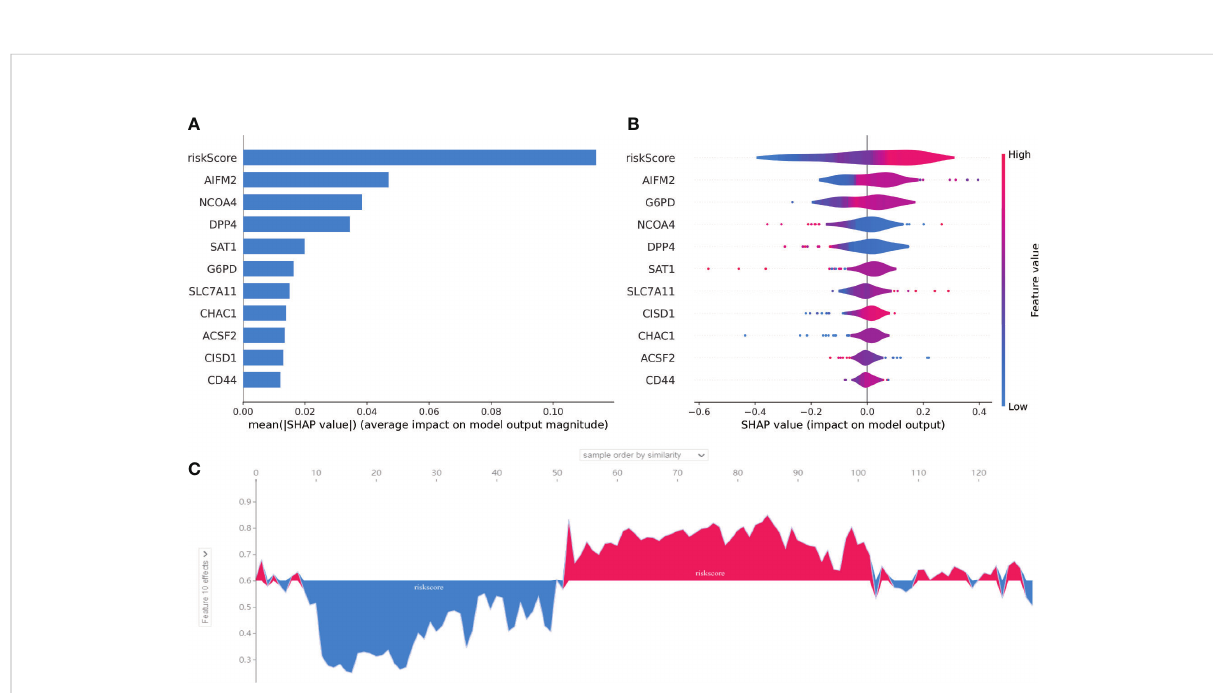
FIGURE 6 SHAP for 10-gene signature. (A) A score calculated by SHAP was used for each input feature. (B) The contribution of each input feature in the overall model. When the SHAP value is positive, if the Future value is mainly red, this feature is a positive correlation. (C) The performance of the riskscore in AML prognosis was assessed by SHAP. The abscissa is to sort each patient according to the riskscore from low to high, and the ordinate is the SHAP value for each patient. Blue represents patient survival and red represents patient